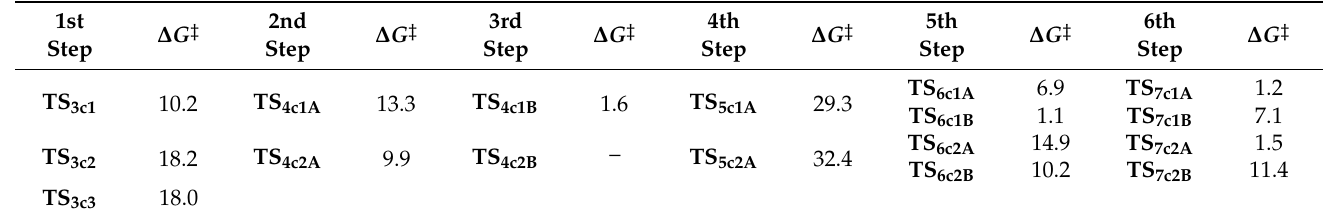
Table 3. Calculated transition states and Gibbs free energies of activation ( ∆ G ‡ , in kcal mol − 1 ) for each step of the mechanism between 1,5-dihydro-1,2,4-oxadiazole and the ynamide MeN(Ms) ≡ CPh.